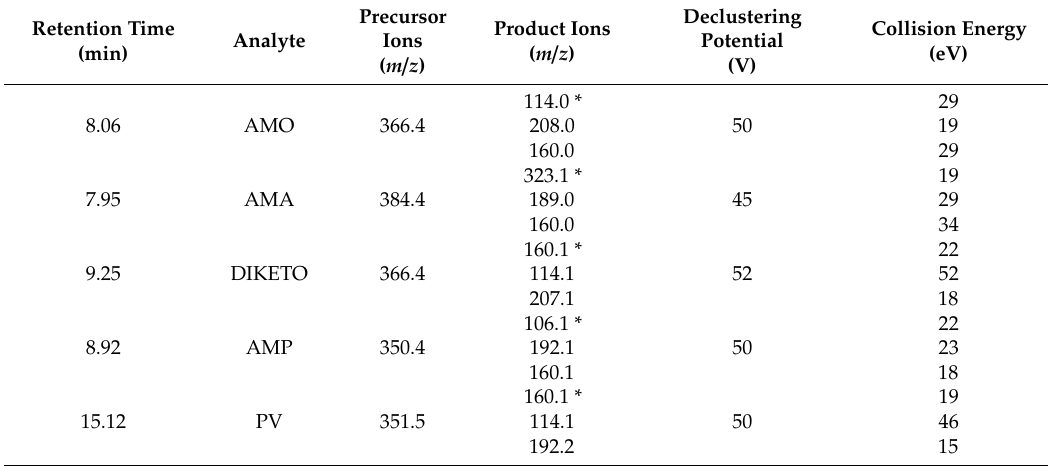
Table 2. Retention times, mass spectral parameters, and molecular weights of the target